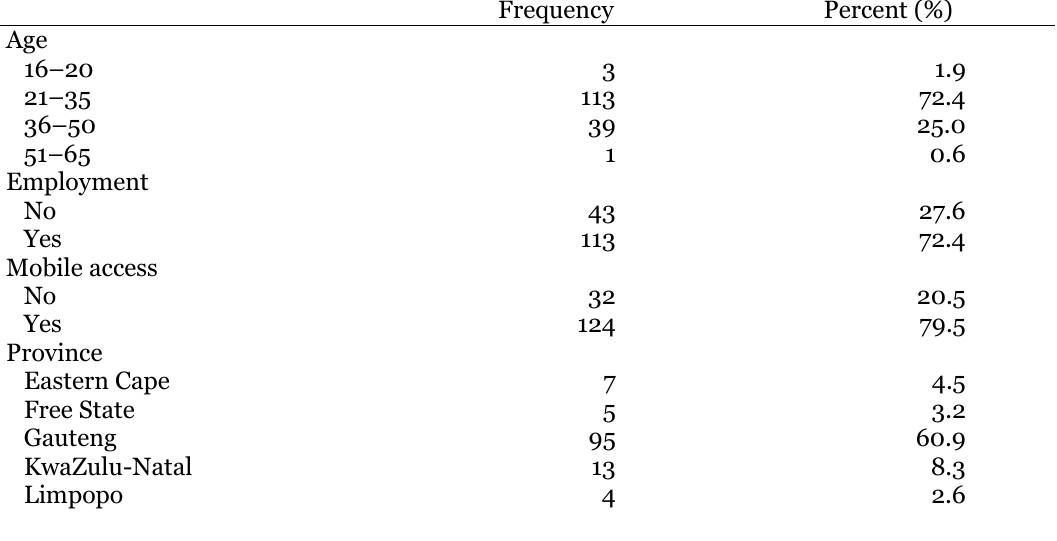
Demographic Profile of the Respondents (N = 156)